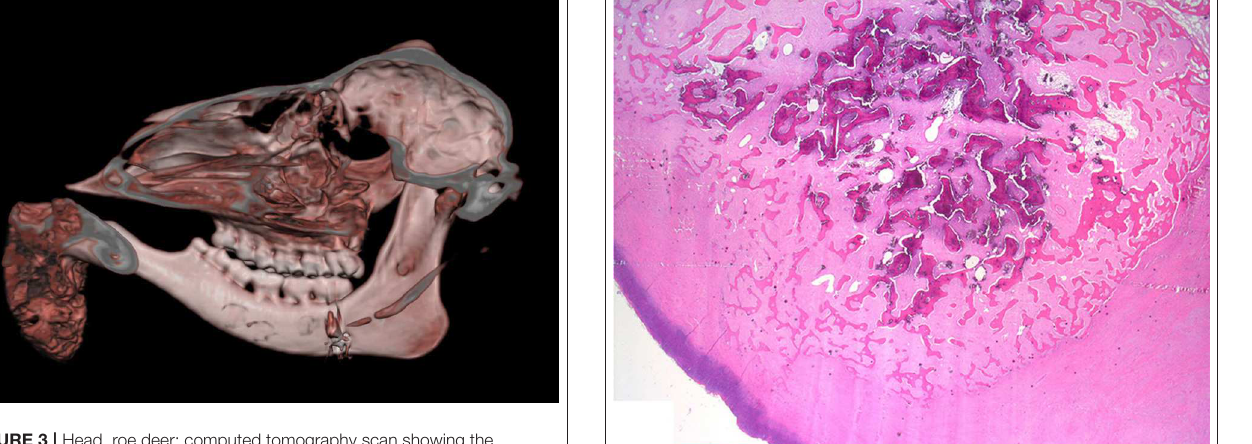
FIGURE 3 | Head, roe deer; computed tomography scan showing the contiguity of the bony mass with the mandible and the effacement of the latter by the tumor. This figure uses volume-rendering technique to provide a three-dimensional image of the skull.